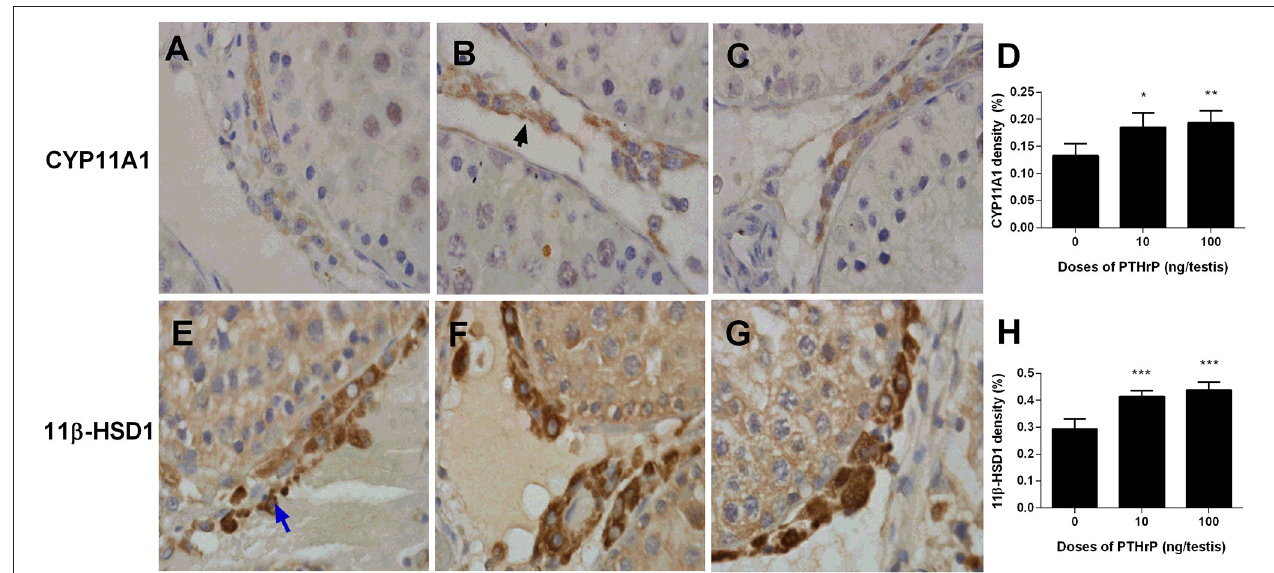
FIGURE 9 | Semi-quantitative measurement of CYP11A1 and 11 β -HSD1 levels of Leydig cells in the testes after in vivo PTHrP treatment. Immunohistochemical staining of CYP11A1 (A–D) and 11 β -HSD1 (E–H) of the testes from the rats treated with 0, 10, and 100 ng/testis PTHrP on post-EDS day 7 for 21 days. (A,E) The control (0 PTHrP); (B,F) 10 ng/testis PTHrP; (C,G) 100 ng/testis PTHrP; (D,H) quantitative data. Black arrow indicates CYP11A1 positive Leydig cells. Blue arrow indicates 11 β -HSD1 positive Leydig cells. Mean ± SEM, n = 6. * P < 0.05; ** P < 0.01; *** P < 0.001 when compared to the control.